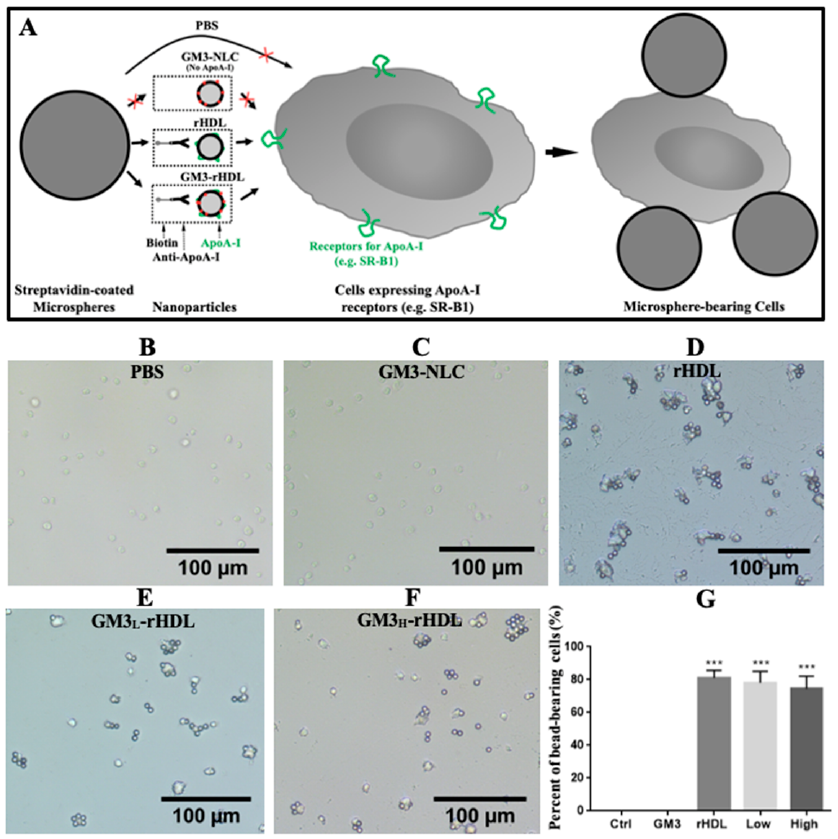
Figure 7. In vitro validation of cell-targeting ability of rHDL and GM3-rHDL nanoparticles via a microsphere-based method. ( A ) Schematic diagram showing the microsphere-based method. The nanoparticles were reacted with anti-ApoA-I-biotin, subsequently conjugated with streptavidin- coated silica microspheres, and incubated with RAW264.7 microphages. ( B – F ) Representative images of microsphere-bearing cells in different groups including PBS buffer, GM3-NLC, rHDL, GM3 L -rHDL, and GM3 H -rHDL, respectively. ( G ) Quantitative analysis (percent of microsphere-bearing cells in all macrophages). *** p < 0.001 ( n = 6) compared with the